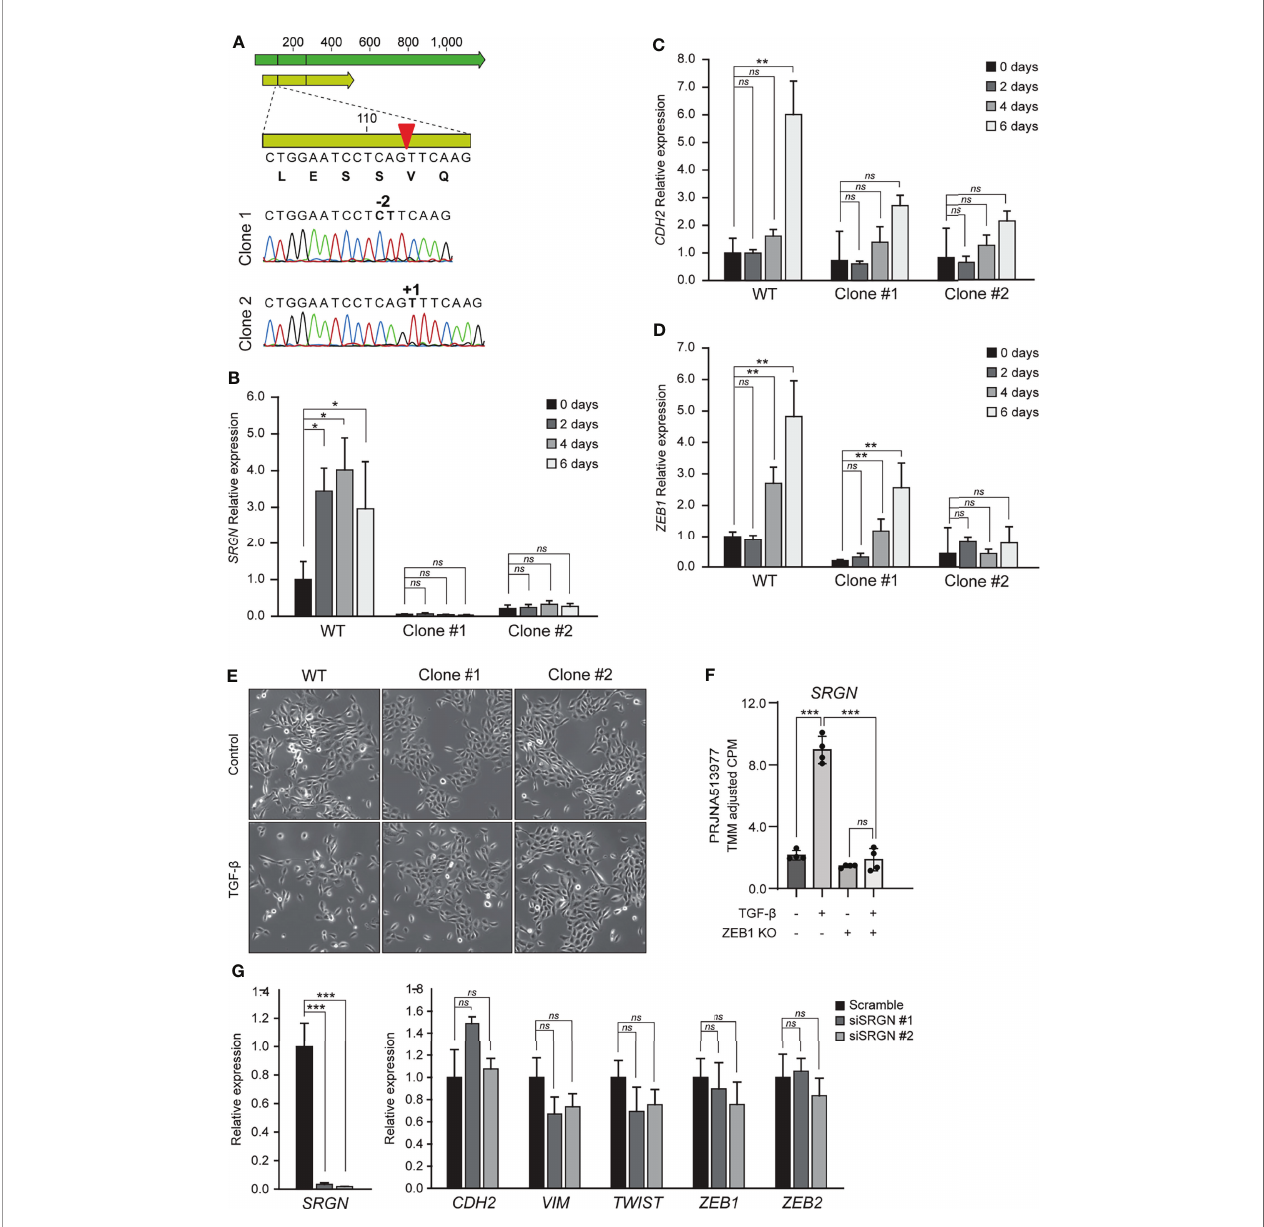
FIGURE 2 | Knockout of serglycin causes a delay in EMT-associated gene expression and morphology. (A) Con fi rmation of CRISPR/Cas9 generation of serglycin knockout clones by Sanger sequencing (bottom part of fi gure). Green arrow, mRNA; yellow arrow, open reading frame; red arrow, CRISPR/Cas9 target site. (B – D) HMLE epithelial cells were stimulated with 10 ng/ml TGF- b for 2, 4, and 6 days and (B) SRGN , (C) CDH2 , and (D) ZEB1 expression were evaluated by RT- qPCR. (E) HMLE epithelial cells were stimulated with 10 ng/ml TGF- b 4 days before imaged using a bright fi eld microscope. (F) Expression of SRGN in MCF10A wild type and ZEB1 knockout cells, with and without TGF- b stimulation. (G) HMLE mesenchymal cells were transfected for 72 hours with control (scramble) or two siRNAs, siSRGN #1, or siSRGN #2, speci fi cally targeting SRGN . SRGN expression and expression of mesenchymal marker genes or EMT transcription factors were evaluated by RT-qPCR. For (B – D) , and (G) the experiments include three biological replicates and are representative for one of a minimum of three independent experimental setups. Error bars represent standard deviation. (***p ≤ 0.001; **p ≤ 0.01; *p ≤ 0.05; ns, not signi fi